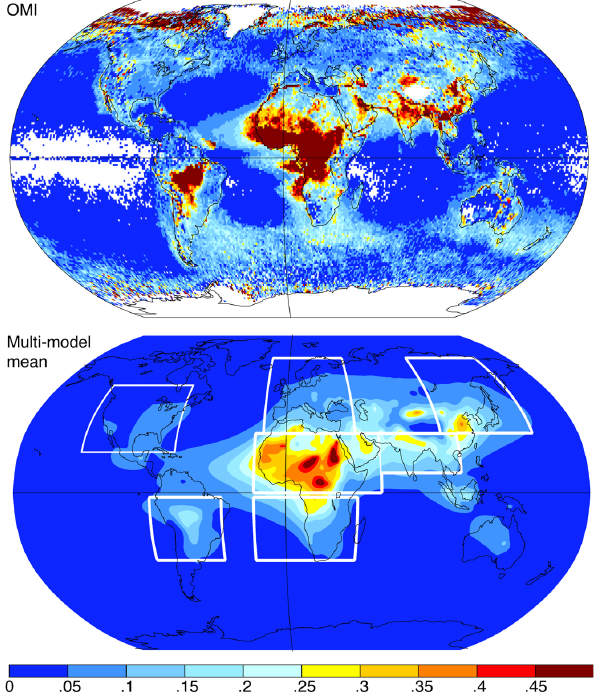
Fig. 6. Annual average AAOD in measurements from the OMI in- strument (top) and in the ACCMIP multi-model mean (bottom). The multi-model mean is from 9 models, with HadGEM2 excluded. OMI retrieval is based on OMAERUVd.003 daily products from 2005–2007 that were obtained through and averaged using GIO- VANNI (Acker and Leptoukh, 2007). White indicates no data in the satellite record. White borders in the lower panel show areas included in regional AAOD analyses. Fig. 7. Modeled and observed annual average AOD trends from